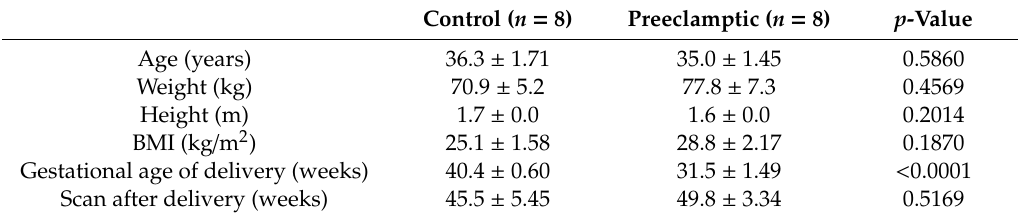
Table 1. Maternal data of human cohort. Cases and controls are matched in age, body mass index (BMI), and scan time after delivery. Preeclamptic women show lower gestational age of delivery. Data given as mean ±